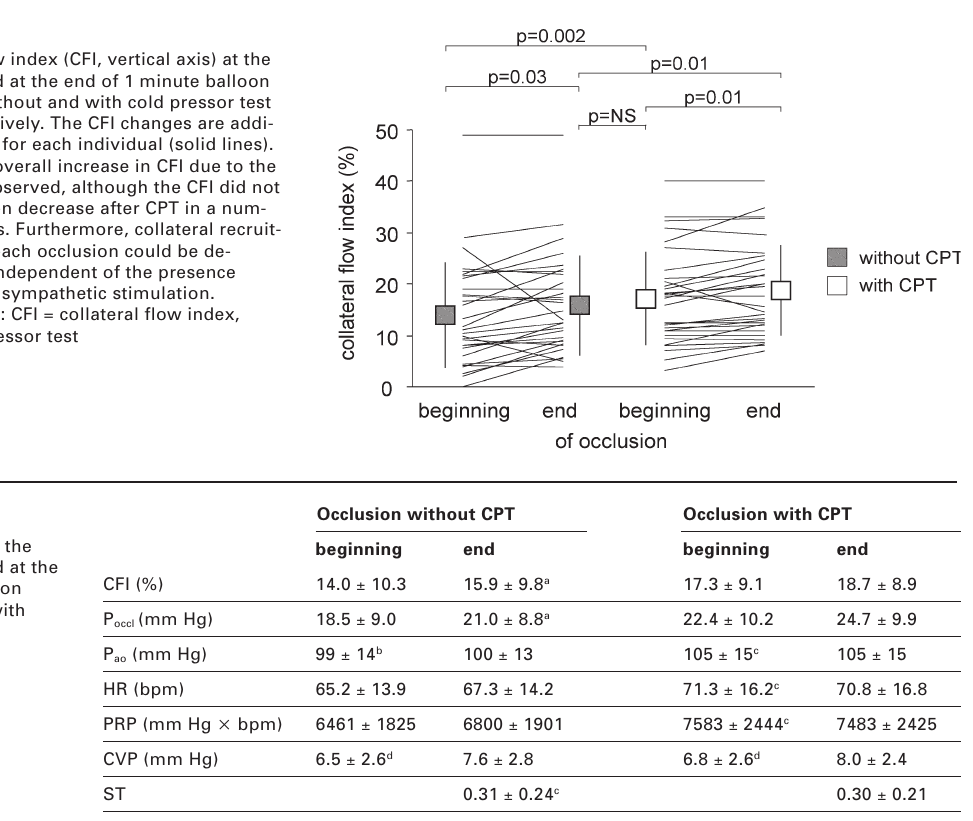
Parameters at the beginning and at the end of occlusion without and with